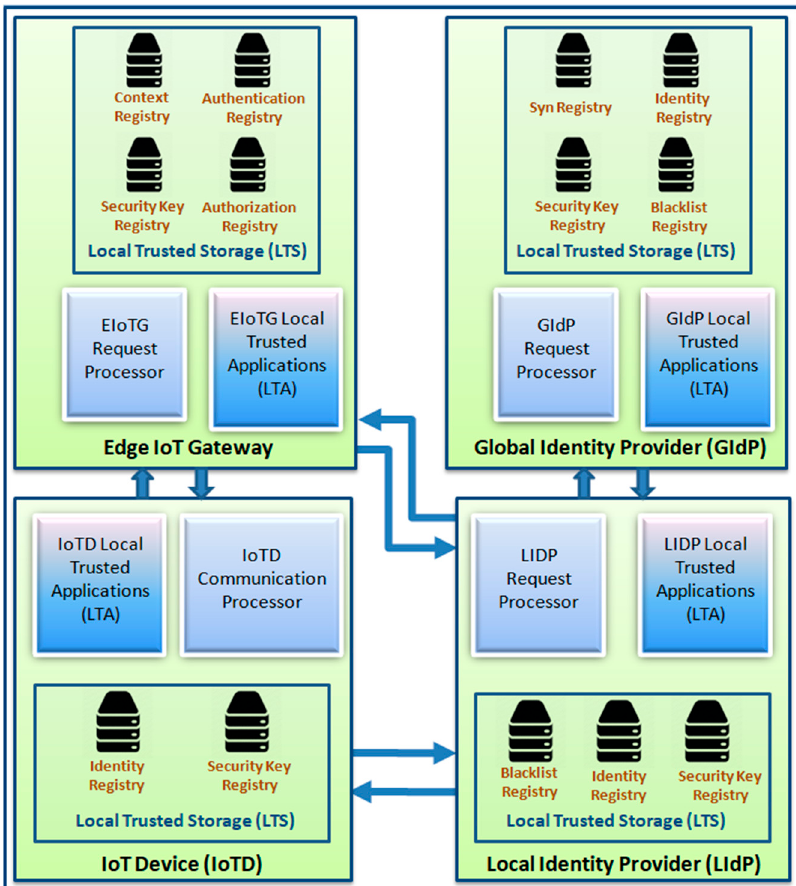
Figure 9. Internal architecture of security communication modules in IoTD, EIoTG, LIdP, and GIdP.